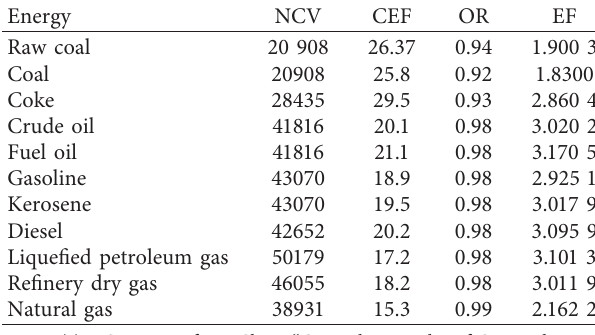
Table 1: The CO 2 emission coefficients of various energy